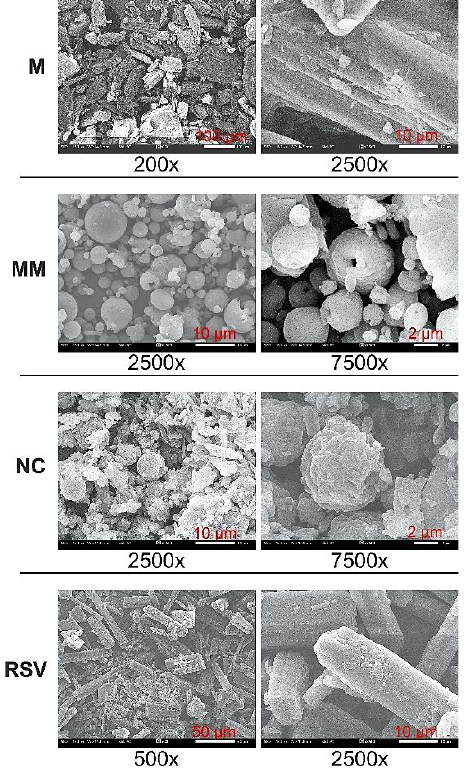
Figure 3. SEM photograph of resveratrol (RSV), mannitol (M), mesoporous mannitol (MM), and nanocrystal (NC, Run 15). Table 1. Statistical analysis, contribution, and goodness-of-fit parameters of screening design